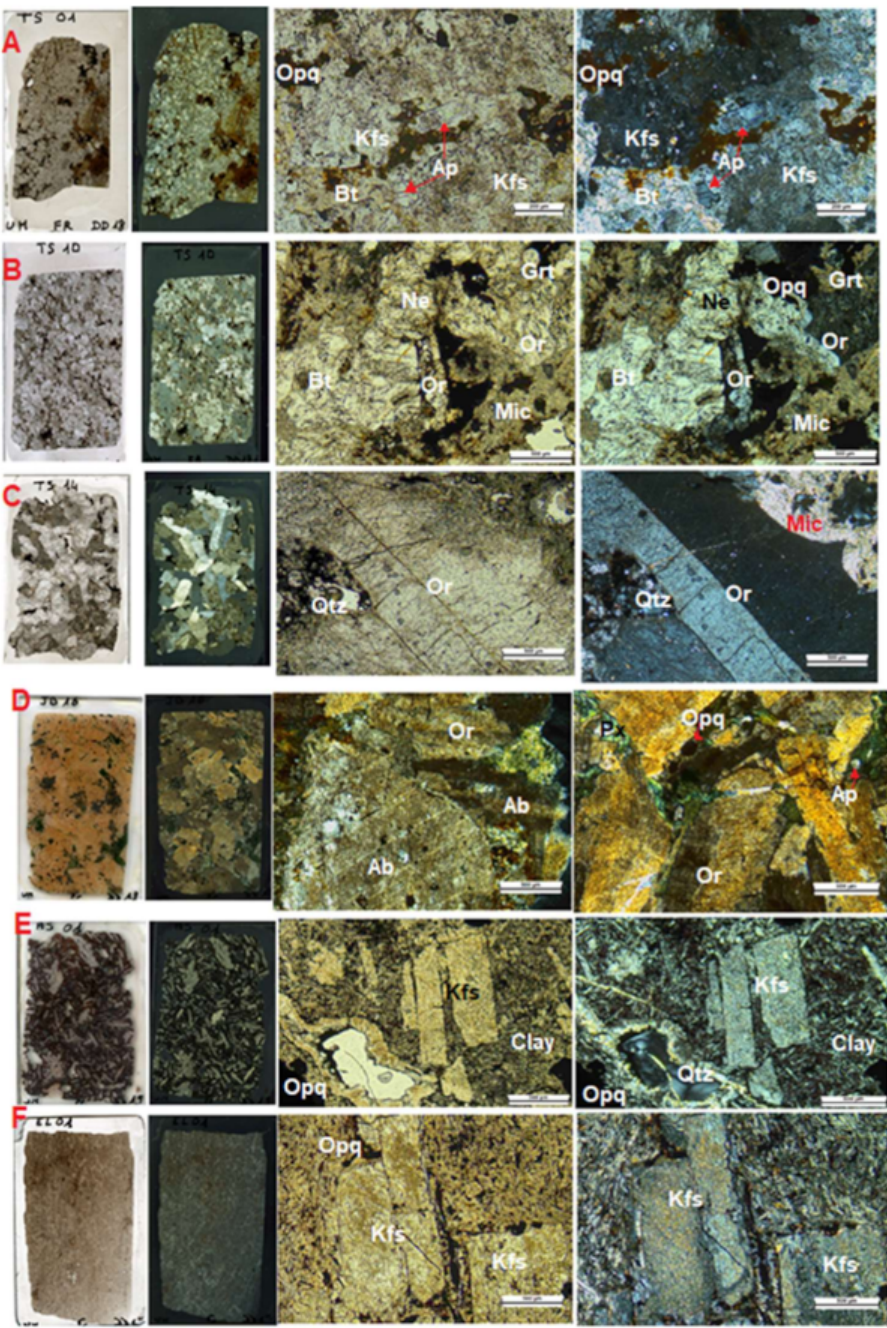
Figure 2. Photo showing the petrography of Tamazeght, Jbel Boho, El Glo’a, and Ait Saoun, samples respectively: ( A )-TS01, ( B )-TS10, ( C )-TS14, ( D )-JB16, ( E )-AS01, and ( F )-EL01 samples. Or: orthoclase, Bt: biotite, Qtz: quartz, Ap: apatite, Ne: nepheline, Ab: albite, Kfs: potassic feldspar, Px: pyroxene, Opq: opaque, and Grt: garnet. Scale bars for ( A ): 200 µ m and ( B – F ): 500 µ